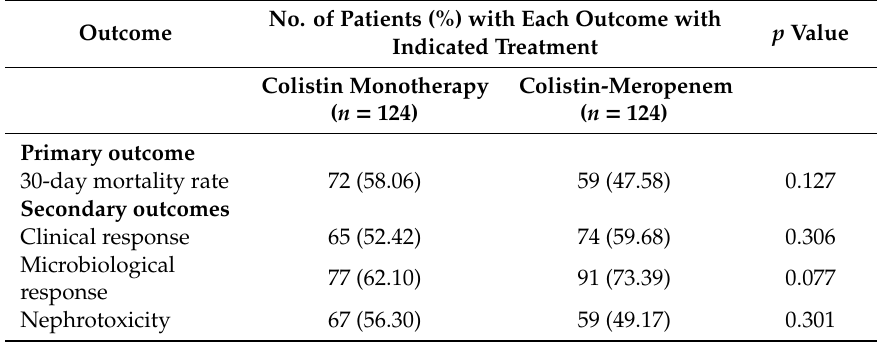
Table 2. Primary and secondary outcomes for the propensity-matched patients who received colistin monotherapy compared to colistin-meropenem combination therapy.